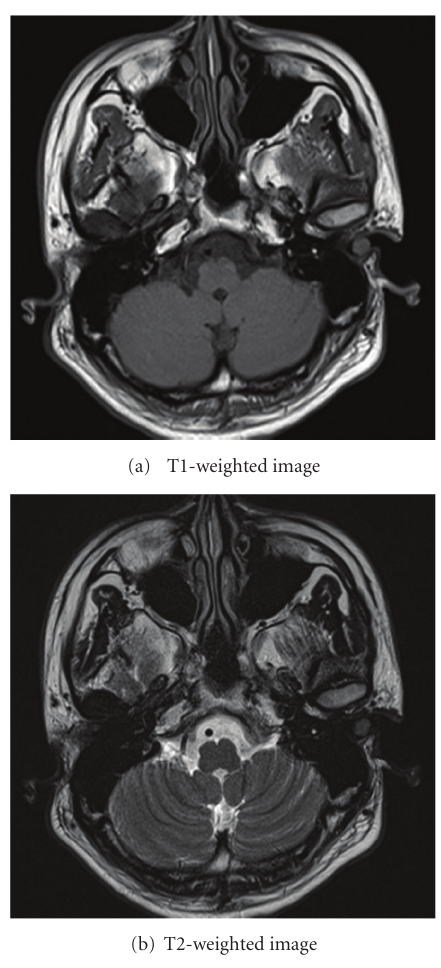
Figure 3: The MR findings: the mass measuring 10X10 mm showed a homogenous, iso signal intensity on a both T1- and T2-weighted